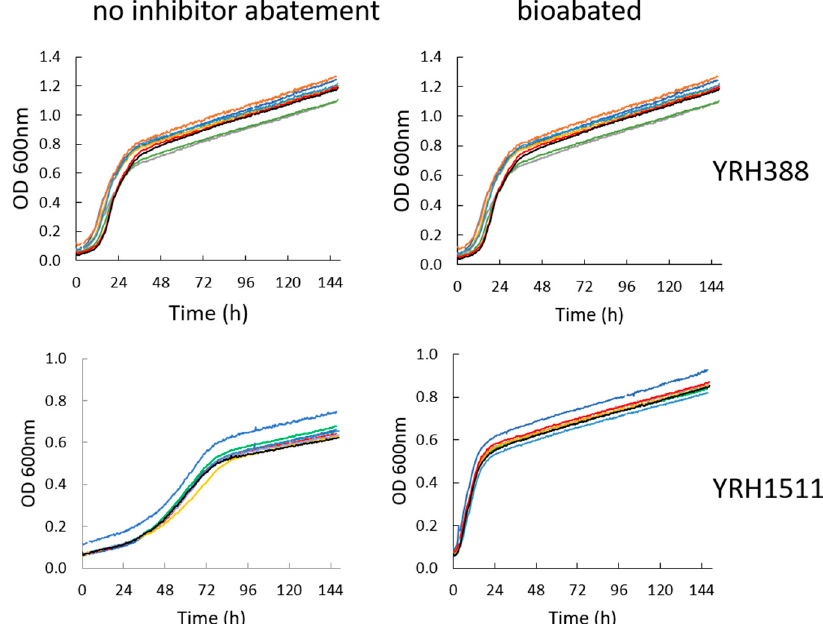
Figure 2. Microwell growth assays of YRH388 and PPP mutant YRH1511 in unabated and bioabated corn stover dilute-acid hydrolysate. Panels show seven or eight replicates (shown as individual lines of various colors) for the indicated strain and hydrolysate. Sugar concentrations are stated in Table 3.